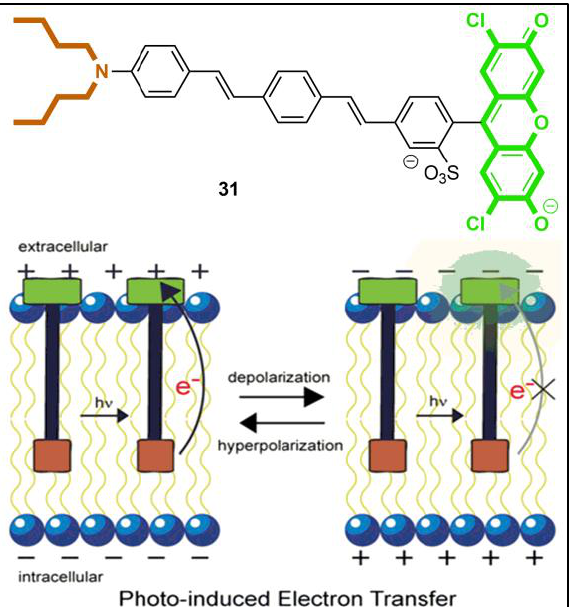
Figure 30. Mechanisms of fluorescent voltage sensing by fluorescent voltage-sensitive dyes (VSDs) [103]. Molecular wire PET 31 depends upon the voltage-sensitive electron transfer from an electron-rich donor (orange) through a membrane-spanning molecular wire (black) to a fluorescent reporter (green). At hyperpolarizing potentials, the electric field is aligned antiparallel to the direction of electron transfer, resulting in efficient PET and quenched fluorescence (left). Depolarization aligns the electric field in the direction of PET, decreasing the rate of electron transfer, and increasing fluorescence (right).